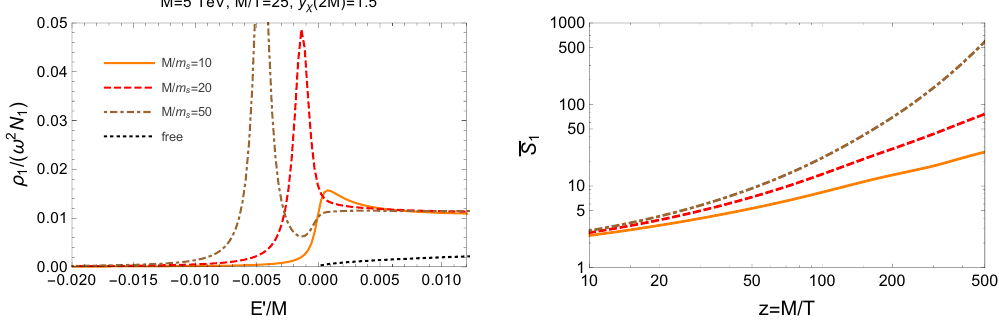
Figure 2 . Left: spectral function of the dark matter pair, here ! = 2 M + E 0 . Three di(cid:11)erent ratios M=m s = 10 ; 20 ; 50 are considered and M = 5 TeV. Right: the thermally averaged Sommerfeld factor (cid:22) S 1 for the same three mass